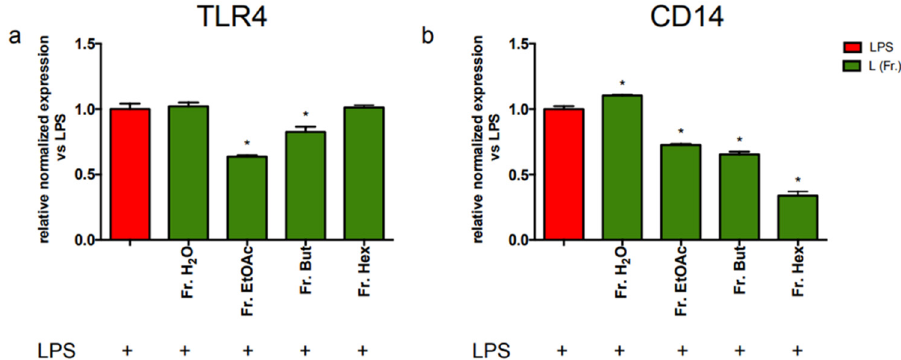
Figure 9. RT-PCR analysis of TLR4 and CD14 gene expression in BV-2 cells treated with different chestnut leaf extract fractions. BV-2 cells were treated for 3 h with 50 µ g/mL of fractions at different polarity (L Fr.), then stimulated with 0.5 μ g/mL LPS for a total of 24 h. At the end of incubation, RNA was extracted from cells and samples were subjected to RT-PCR analysis using a specific primer for TLR4 ( a ) and CD14 ( b ), as reported in the Materials and Methods section. The relative mRNA contents of TLR4 and CD14 were normalised to LPS-treated cells (red bars). Relative quantification is obtained as described in the Materials and Methods section, and results are expressed as means ± SEM of three independent experiments. Statistical analysis was performed by Fisher’s LSD test following one-way ANOVA. * p < 0.05 significantly different from LPS-treated cells.